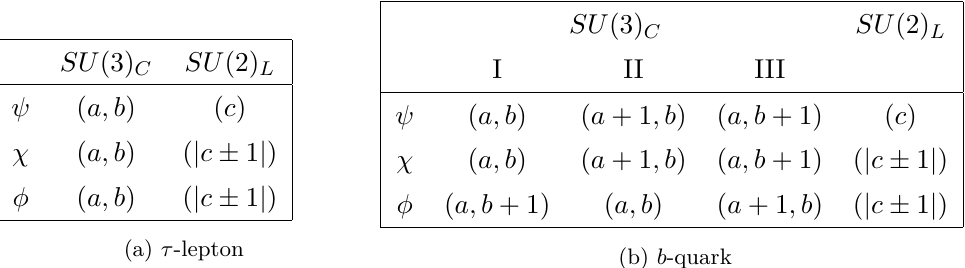
Table 5. Dynkin labels giving the allowed colour and weak-isospin assignments of the new fields in Class 2 for the τ -lepton (left) and b -quark (right). For the b -quark models there are three possible patterns for the SU (3) C